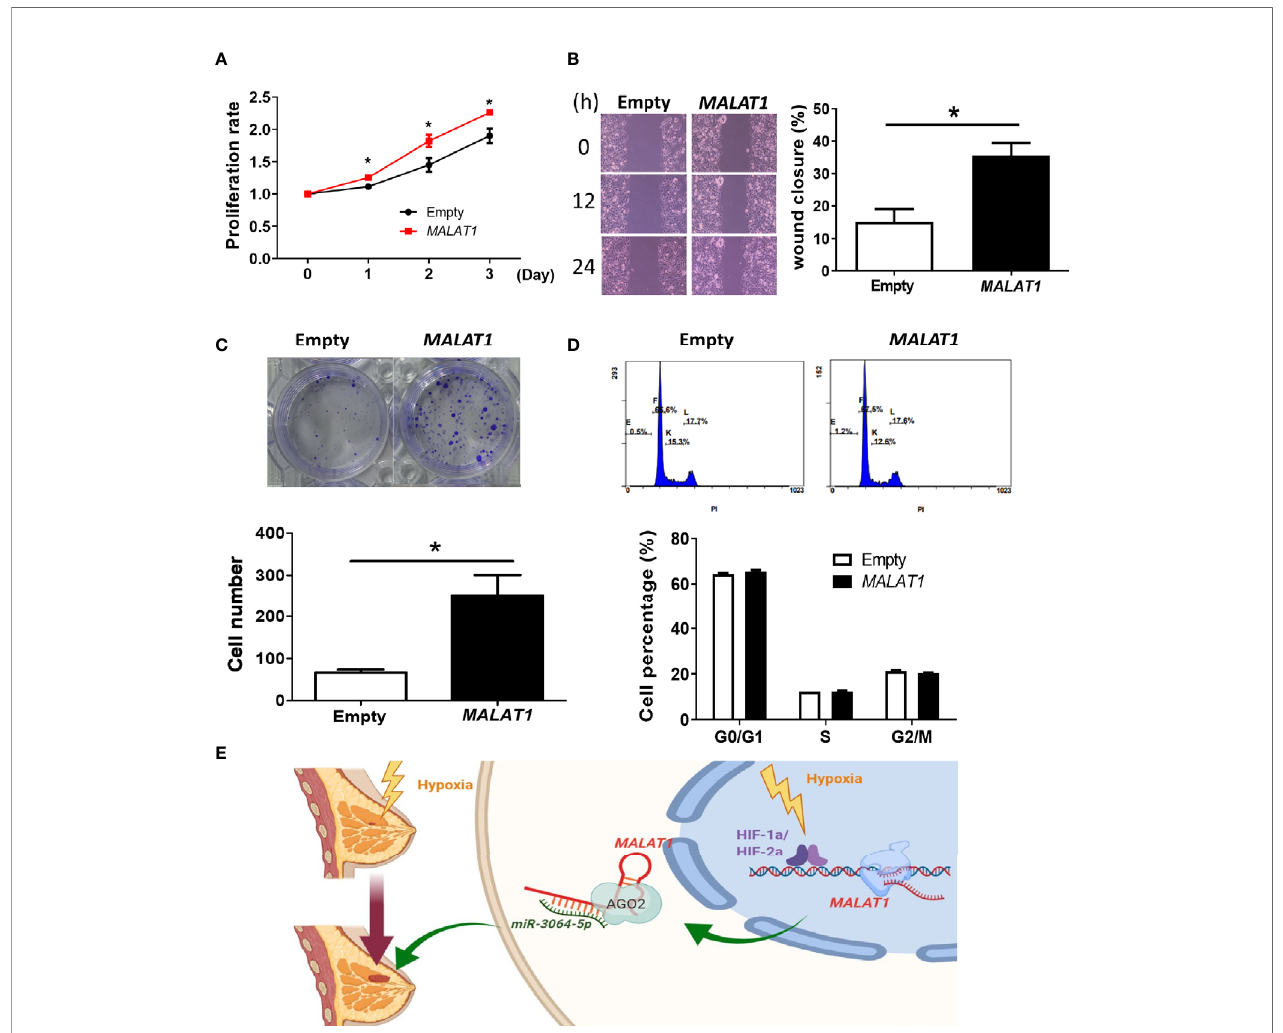
FIGURE 7 | Overexpression of MALAT1 promotes proliferation and migration in MCF-7 cells. (A) Measurement of cell proliferation using MTT assays. Cell growth was measured in MCF-7 cells overexpressing MALAT1 . The proliferation rate was normalized to day zero. (B) Wound healing assay. Left: Representative pictures of wound healing assays. After 24 h of transfection, wound healing was photographed at 0, 12, and 24 h. Right: Migration ability was quanti fi ed as reduction in wound size at 24 h. (C) Colony formation assay. Top: Representative pictures of colony formation assays. Colonies with cell numbers more than fi fty were counted. Bottom: Quanti fi cation of results. (D) Cell cycle distribution by fl ow cytometry. Top: Representative diagrams of fl ow cytometry. After 48 h of transfection, cells were harvested and stained with PI. Bottom: Quanti fi cation of results as the percentage of cells in each phase of the cell cycle. (E) A proposed model for illustrating the regulatory mechanisms and function of hypoxia-induced lncRNA MALAT1 in breast cancer cells. All data shown are the means ± SDs (n = 3). * P <